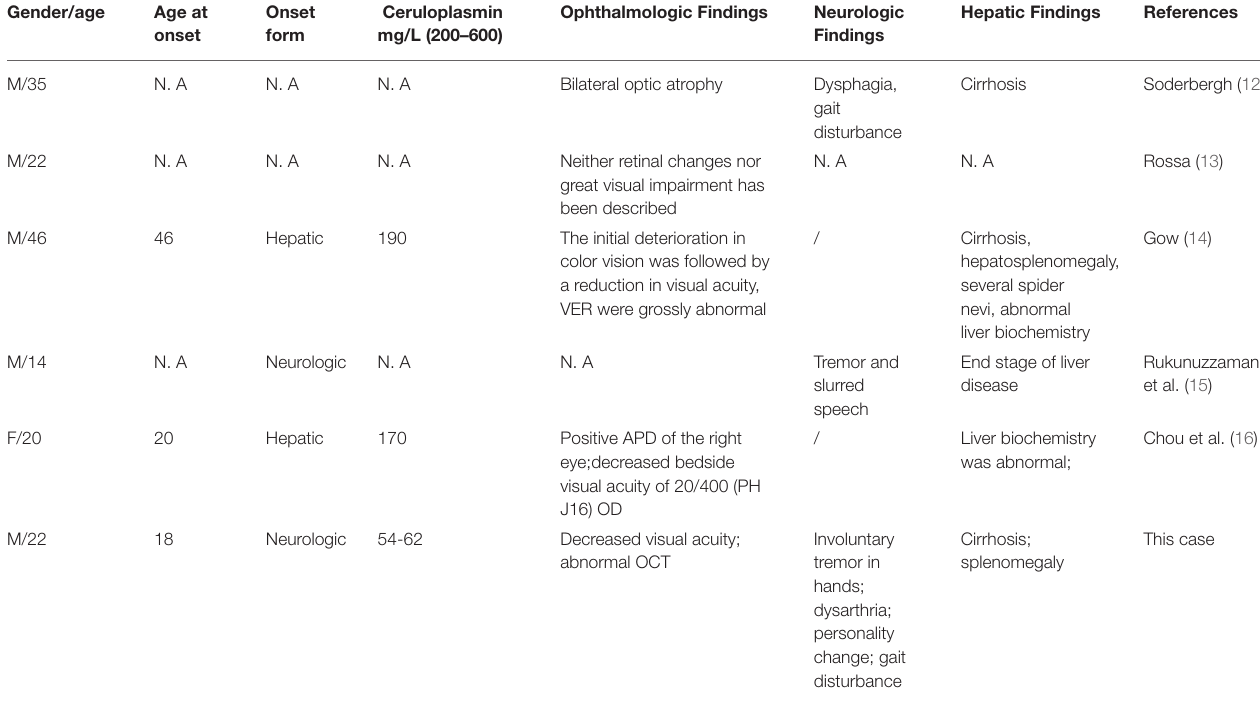
TABLE 1 | Previously reported cases of Wilson’s disease (WD) with acute-onset visual impairment.